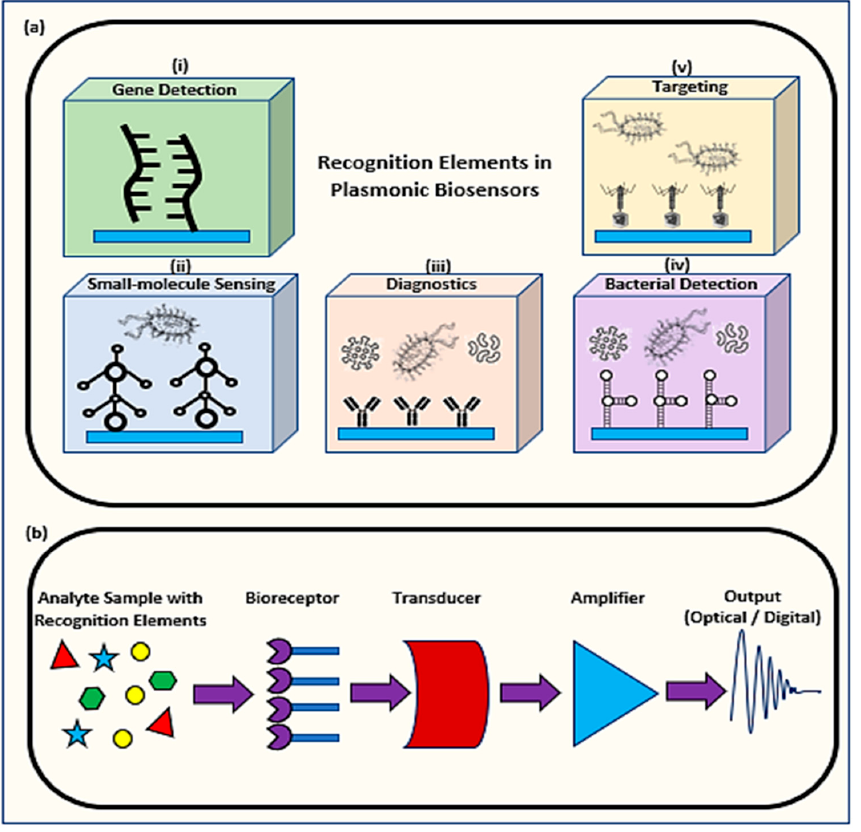
Figure 1. A schematic diagram of ( a ) recognition elements in plasmonic biosensors in (i) gene detection between electrochemical DNA and target DNA, (ii) small-molecule sensing for analyte-antibody conjugation, (iii) diagnostics between antibodies and analytes, (iv) bacterial detection between receptor biomolecule and bacteria, (v) targeting specific biomolecules and ( b ) the parts forming biosensors including a bioreceptor to capture the analyte connected to a transducer to convert the sample to be amplified and digitally presented.